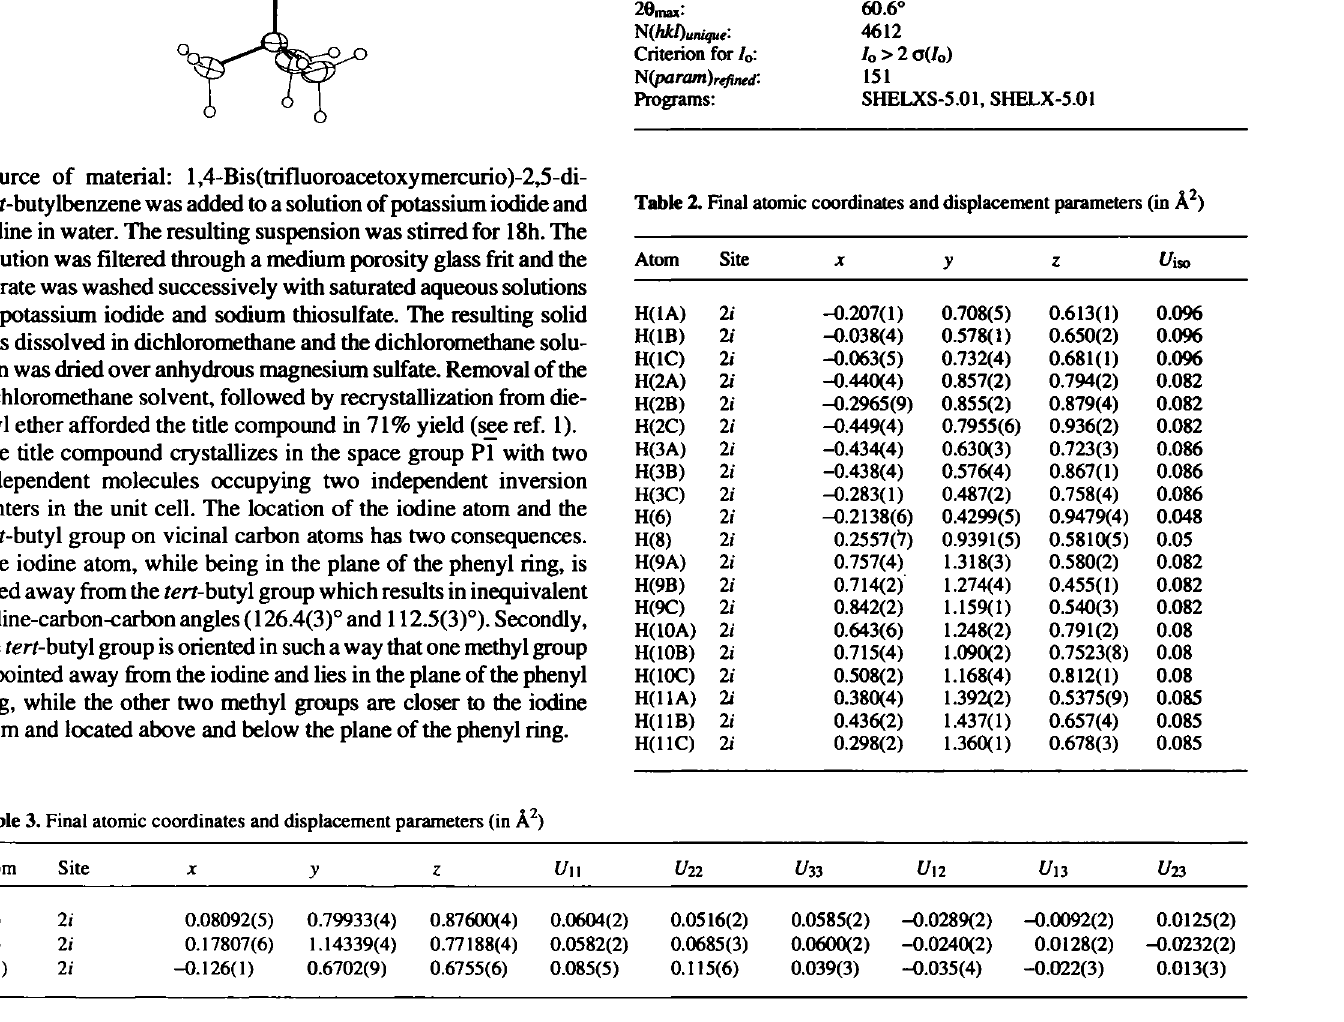
Table 1. Parameters used for the X-ray data collection